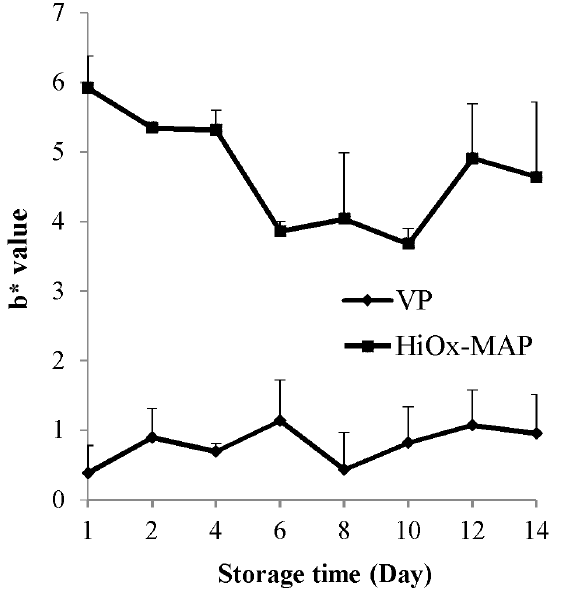
Figure 3. Effects of vacuum packaging (VP) and high-oxygen modified atmosphere packaging (HiOx-MAP, 80% O water buffalo meat at 2°C±0.5°C for 14 days.